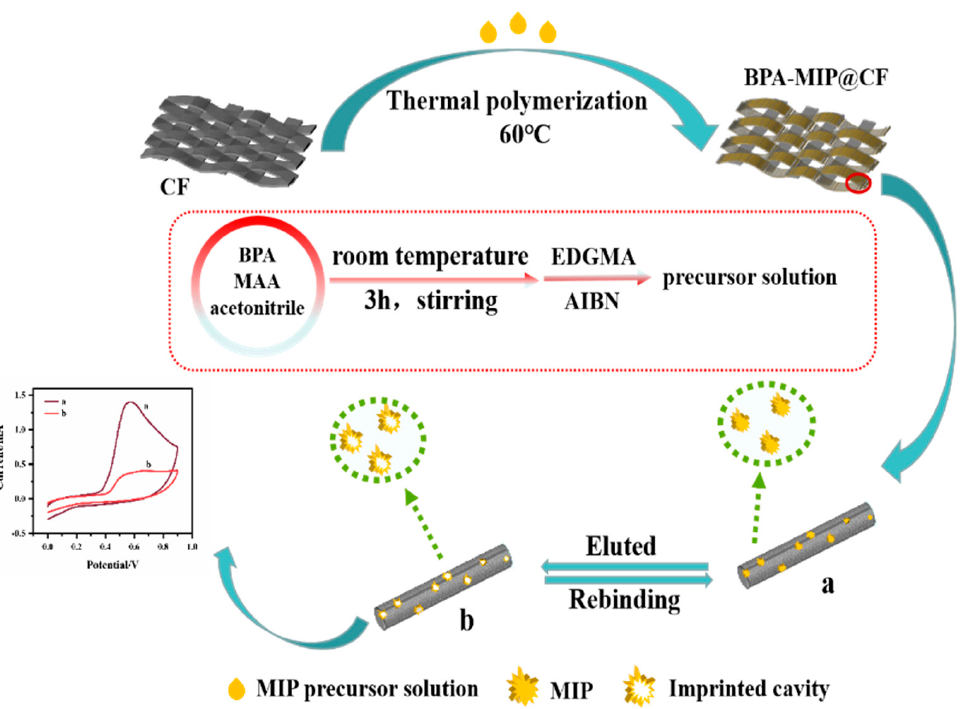
Figure 1. Schematic illustration of the preparation and application of MIP@CF sensor for the detection of BPA.